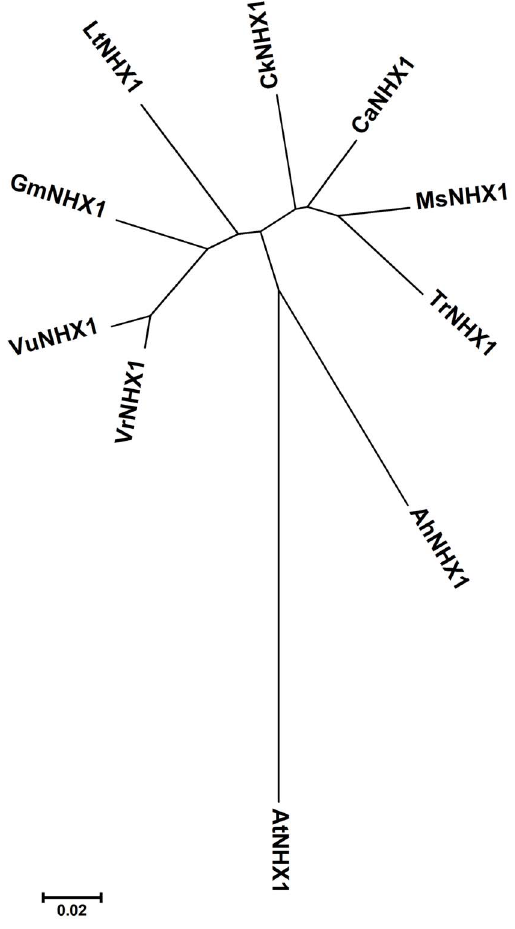
Figure 1. The phylogenetic tree for plant Na + /H + antiporters was generated using MEGA4: Tree Explorer software. The evolutionary history was inferred using the neighbor-joining method and analyzed using bootstrap analysis with 500 replicates. Branches corresponding to partitions reproduced in less than 50% bootstrap replicates are collapsed. The tree is drawn to scale, with branch lengths in the same units as those of the evolutionary distances used to infer the phylogenetic tree. The evolutionary distances were computed using the Poisson correction method and are in the units of the number of amino acid substitutions per site. The GenBank Accession numbers